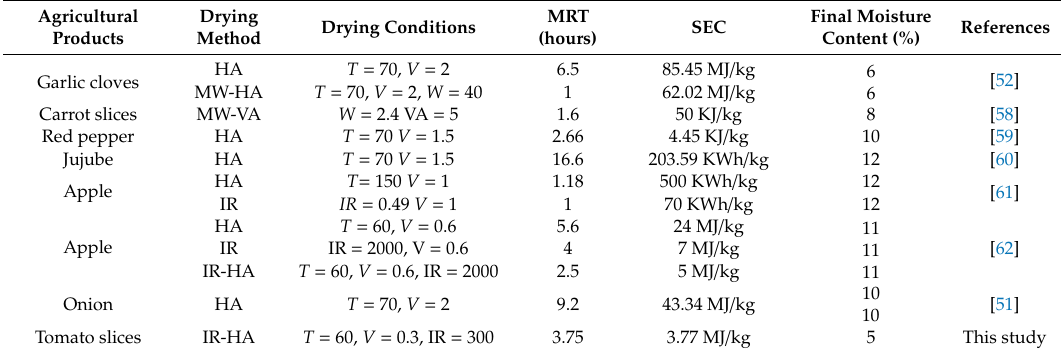
Table 1. A comparison between the results obtained in this study and that from the literature when considering the minimum required time (MRT) and specific energy consumption (SEC) for drying di ff erent biomasses when applying the combined infrared-hot air convection drying system.